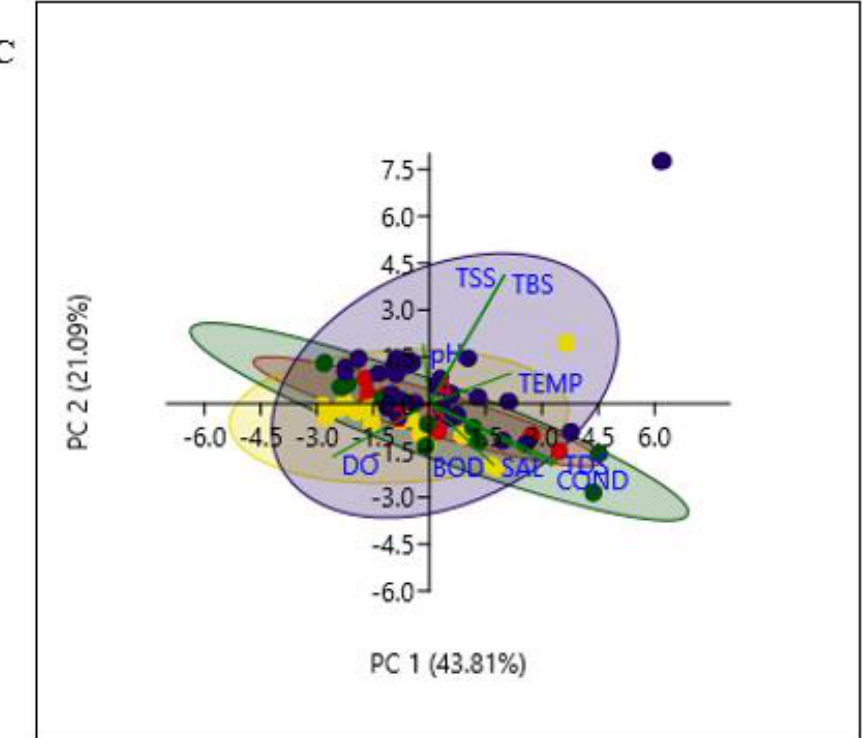
Figure 1. Seasonal changes in the physicochemical variables in ( A ) Great Fish, ( B ) Keiskamma and ( C ) Tyhume, rivers. Principal component analysis of the physicochemical variables in each river across the four seasons: (1) Autumn ( • ), (2) Winter ( • ), (3) Spring ( • ) and (4) Summer ( • ). The lengths and directions of the Biplots vectors explain the association between the variables and the seasons. Measurement of physicochemical variables of freshwater resources was done in three replicates (n =